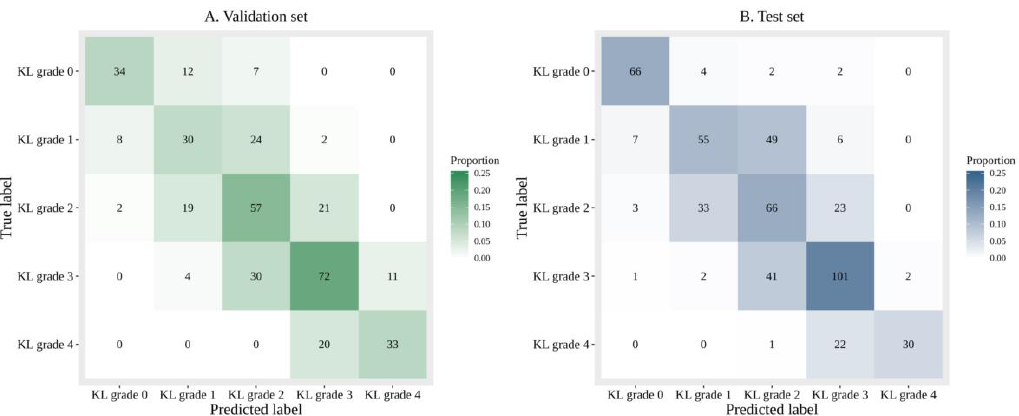
Figure 4. Confusion matrices of predicted and ground truth labels image data and additional patient information.